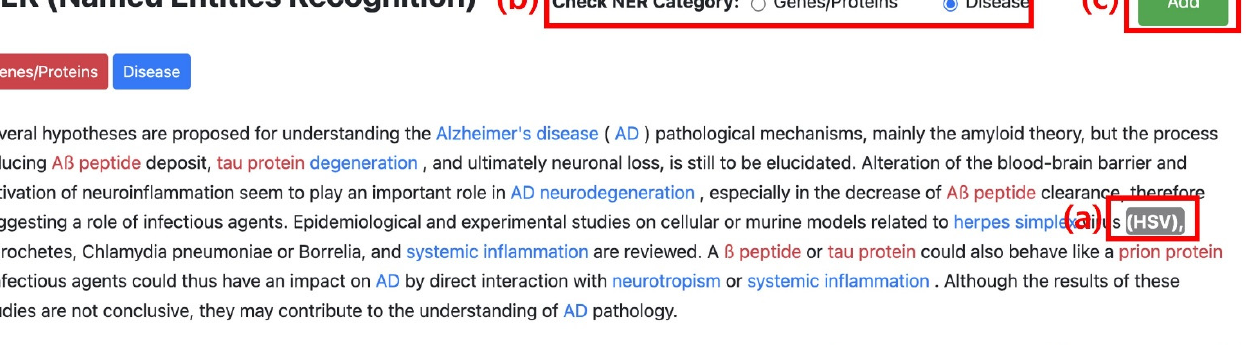
Figure 9. User-defined NE annotation information added to the information. Red box highlights terms that the user has manually annotated. The added NE annotation information is applied in red for the genes/proteins cate- gory and in blue for the disease category, just as the existing tagged information is dis- played. This change not only informs the user that a new annotation has been added, but also generates a new fine-tuning dataset by gathering manually annotated phrases. This dataset can be used to retrain the model. 4.3. Model Retraining The new dataset created using the implemented web service can be used for model retraining to increase user-customized inference accuracy. Because there may be missing results in the previously learned dataset, our tagging tool enables users to generate a more